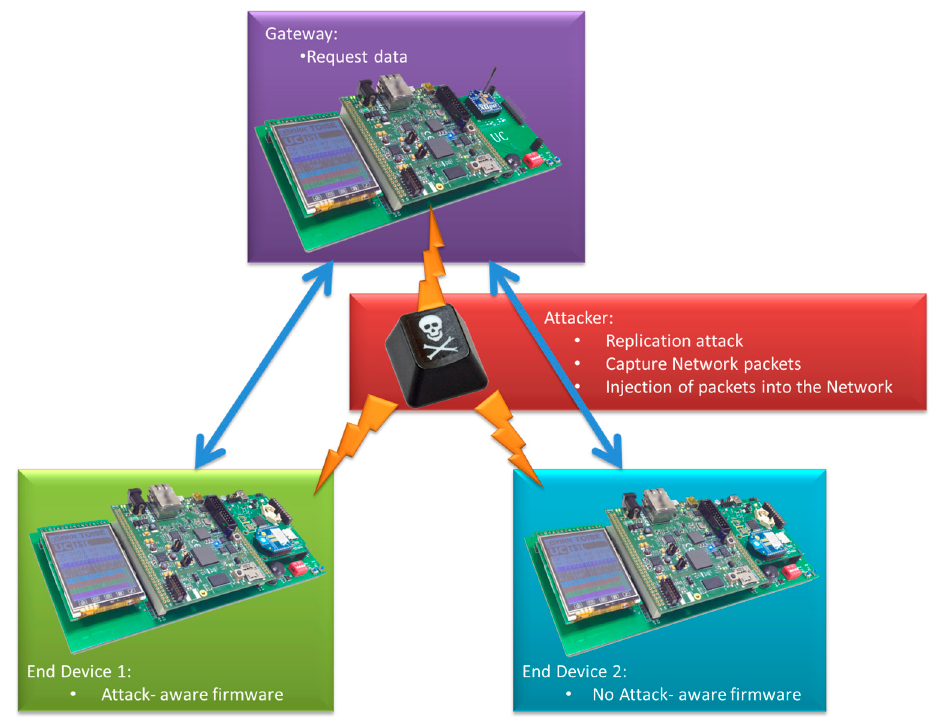
Figure 12. Network topology for accuracy evaluation.